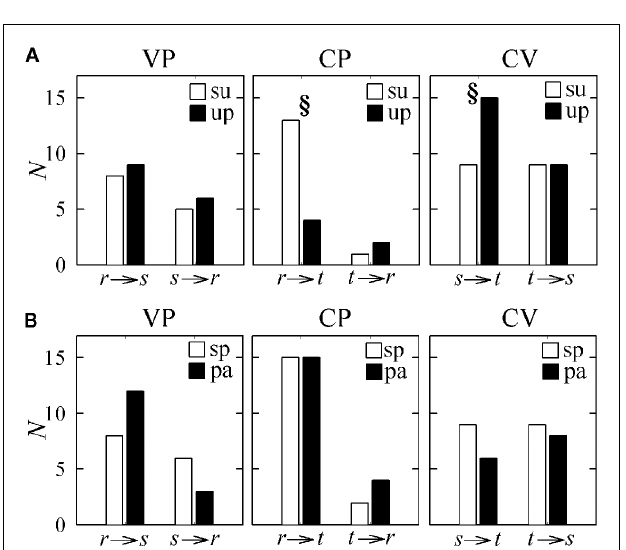
FIGURE 7 | Number of subjects ( N ) for which at least one candidate term of the input series is selected in the causality analysis (i.e., the causal coupling index is non-zero) during the tilt test protocol [(A); su: supine position; up: upright position] and during the paced breathing protocol [(B); sp: spontaneous breathing; pa: paced breathing] in the study of vasculo-pulmonary (VP), cardio-pulmonary (CP), and cardio-vascular (CV) coupling ( r : respiration, s : systolic pressure; t : heart period). § p < 0.05, su vs. up or sp vs.